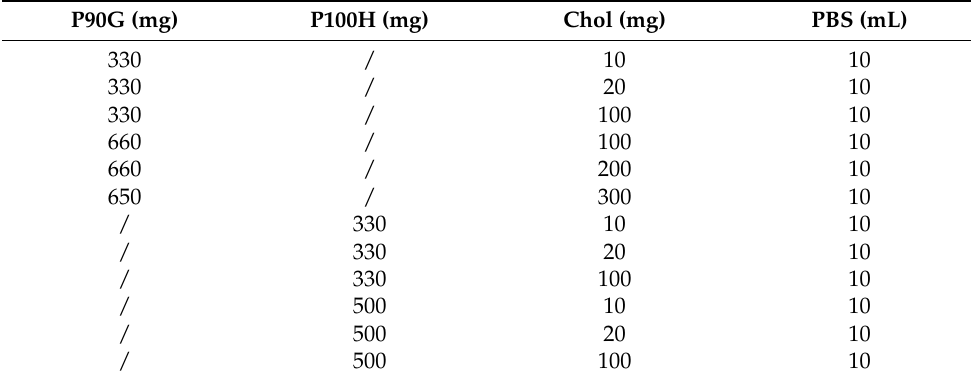
Table 1. Different combinations of lipids for the preparation of nanoliposomes.